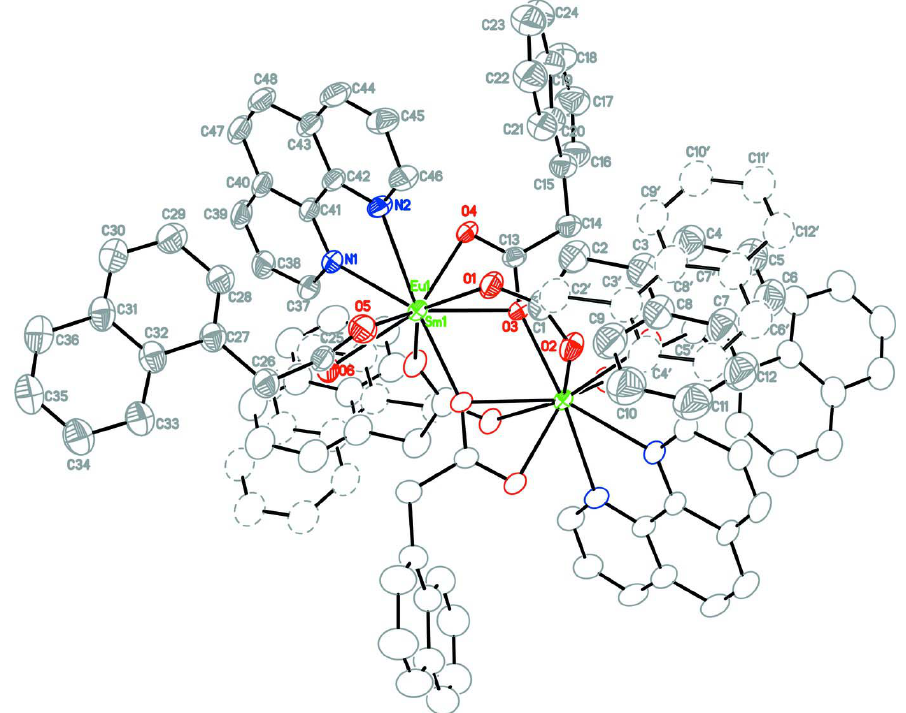
0.628 (14) and 0.372 (14), respectively.